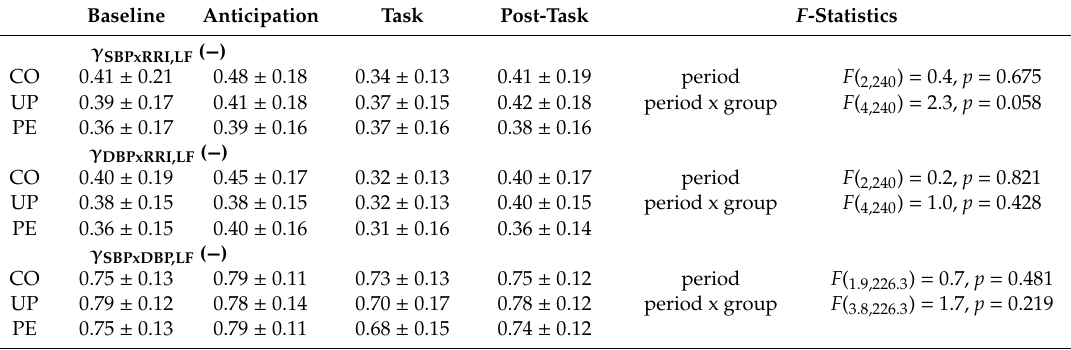
Table 3. Phase synchronization indices of the low-frequency (LF) components (mean ± SD) of participants, and statistical results for group di ff erences in response to the stress manipulation. CO: women without gestation during the last three years; UP: women with uncomplicated pregnancies; PE: women with a history of preeclampsia; γ : synchronization index; SBP: systolic blood pressure,